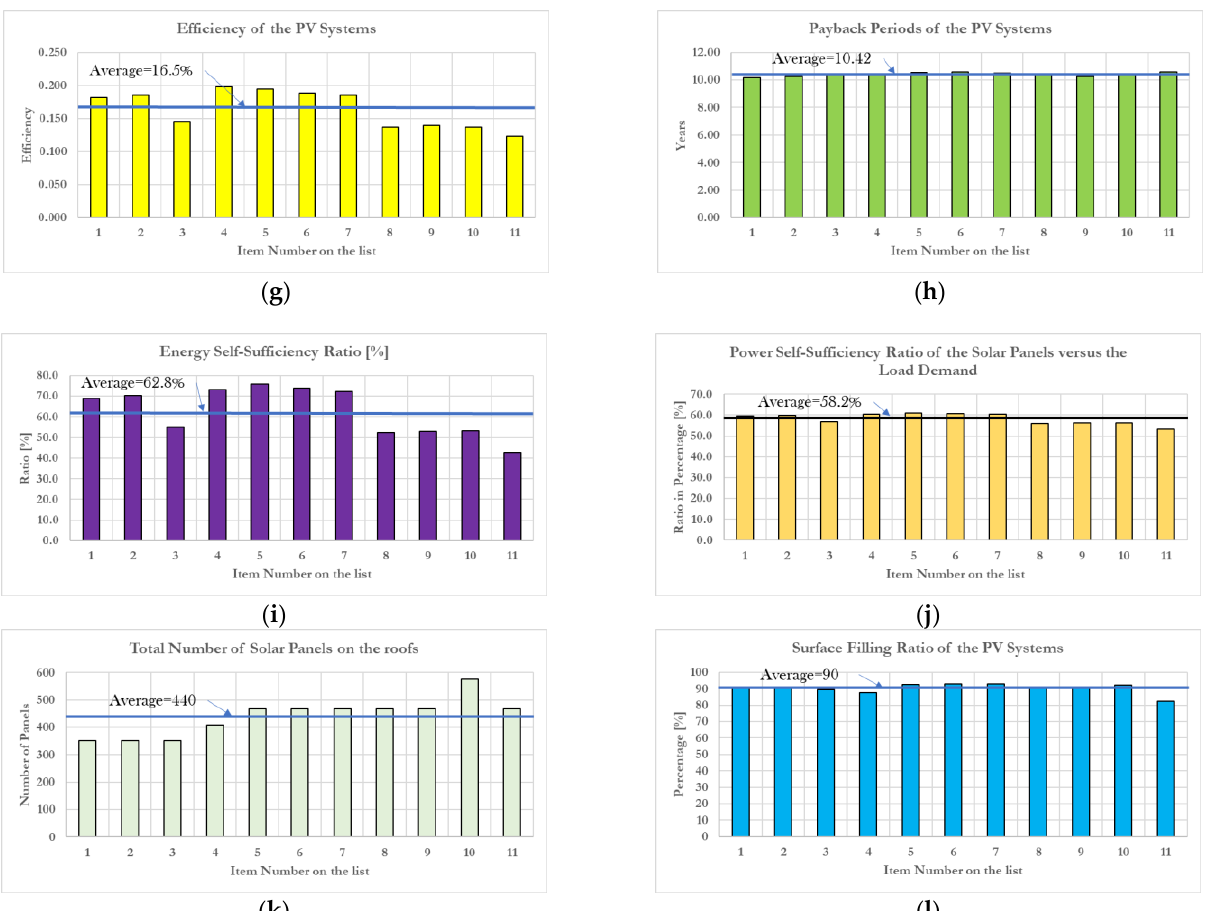
Figure 7. Output results of the 11 different solar panels calculated by the proposed optimization algorithm ( a ) PTC under standard test condition of the solar panels, ( b ) total installed cost per module of the solar panels, ( c ) total power generation of the systems, ( d ) total installation cost of the systems, ( e ) cost to power generation ratio of the systems, ( f ) cost to energy generation ratio of the systems, ( g ) efficiency of the PV systems, ( h ) payback periods of the PV systems, ( i ) energy self-sufficiency ratio, ( j ) power self-sufficiency ratio of the solar panels versus the load demand, ( k ) total number of solar panels on the roofs, ( l ) surface filling ratio of the PV systems.